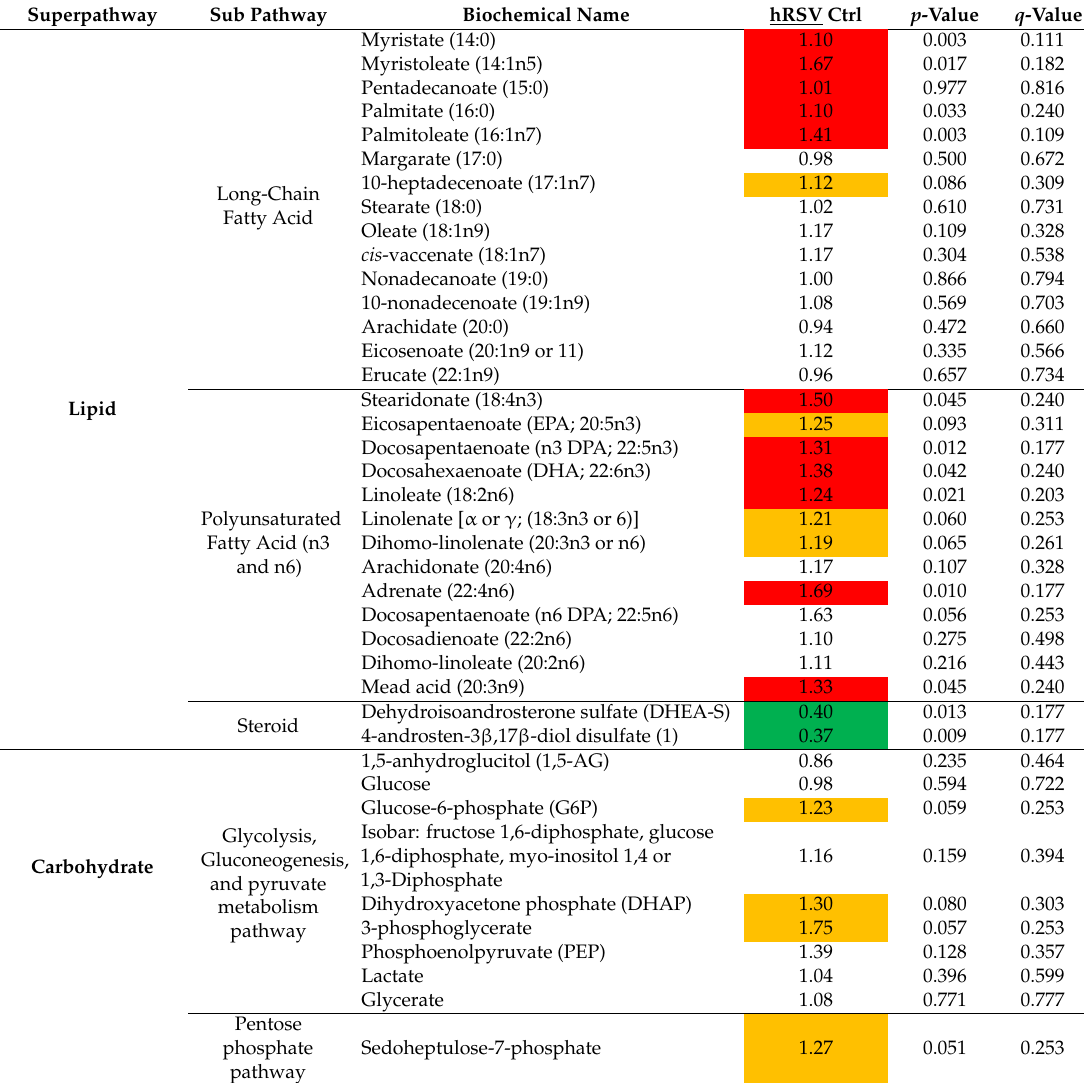
Table 2. Summary of resveratrol-induced changes in adipose tissue. Identified metabolites in the long-chain fatty acid, polyunsaturated fatty acid (n3 and n6), steroids, glycolysis, gluconeogenesis, and pyruvate metabolism, and pentose phosphate pathways in adipose tissue. Red: Significant elevation ( p ≤ 0.05). Orange: Trending elevation ( p < 0.10); Green: Significant reduction ( p ≤